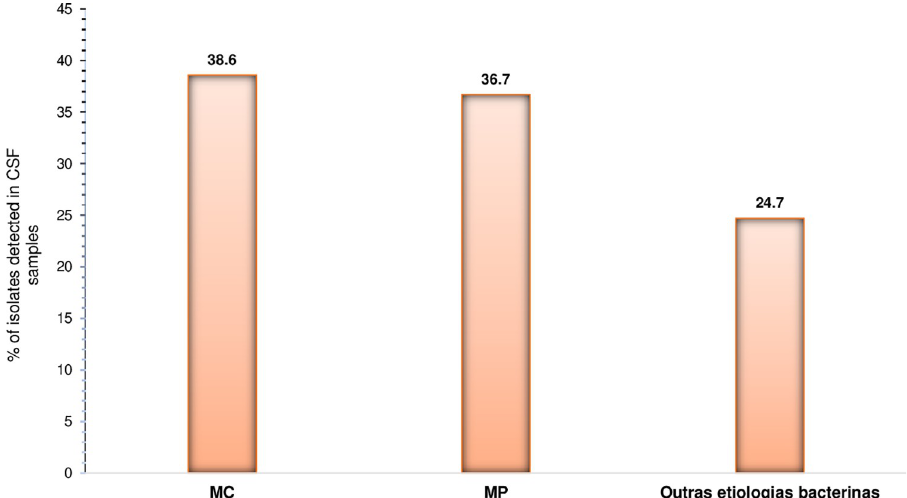
Fig 1. Proportion of confirmed bacterial and fungal meningitis cases in Mozambique in the period between January 2016 and December 2017. This figure shows the proportion of pathogens causing bacterial and fungal meningitis among adults in Mozambique in the period between January 2016 and December 2017.